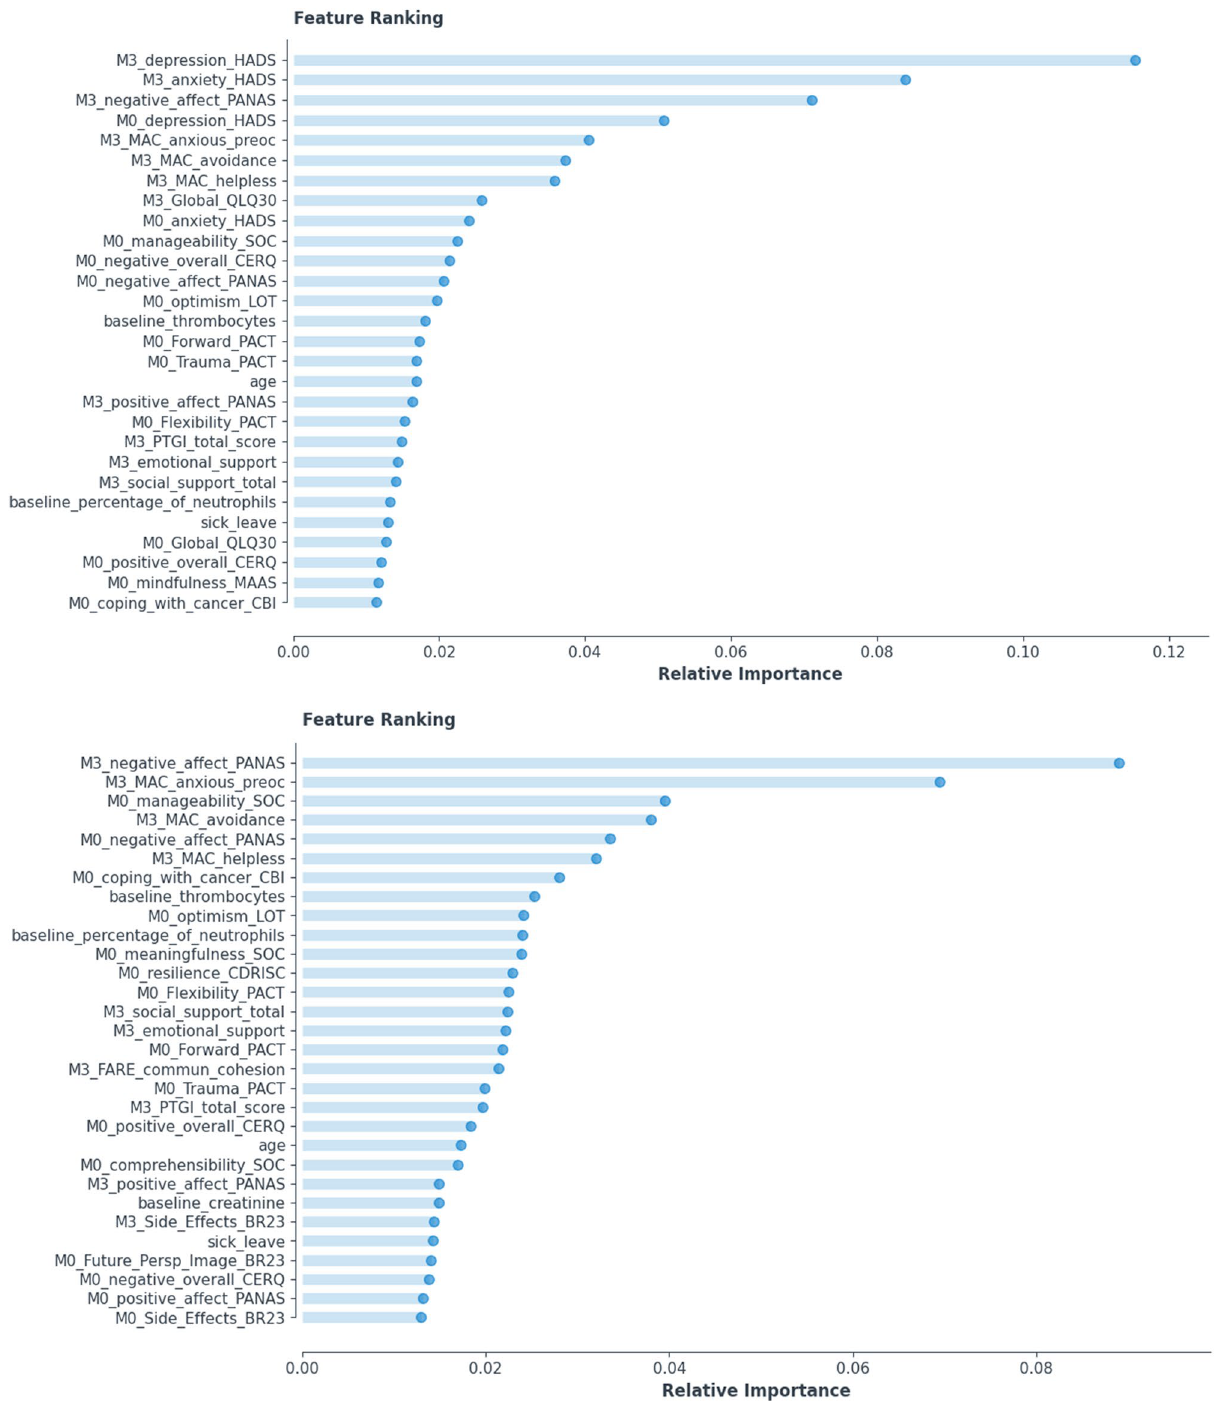
Figure 1. The selected features for Model 1 (upper panel) and Model 2 (lower panel) ranked according to their relative importance for prediction of mental health change between M0 and M12. M0 indicates variables assessed at baseline and M3 variables assessed at